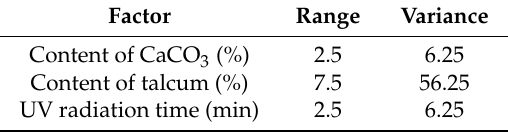
Table 3. Range and variance of synergistic modification of talcum and calcium carbonate.